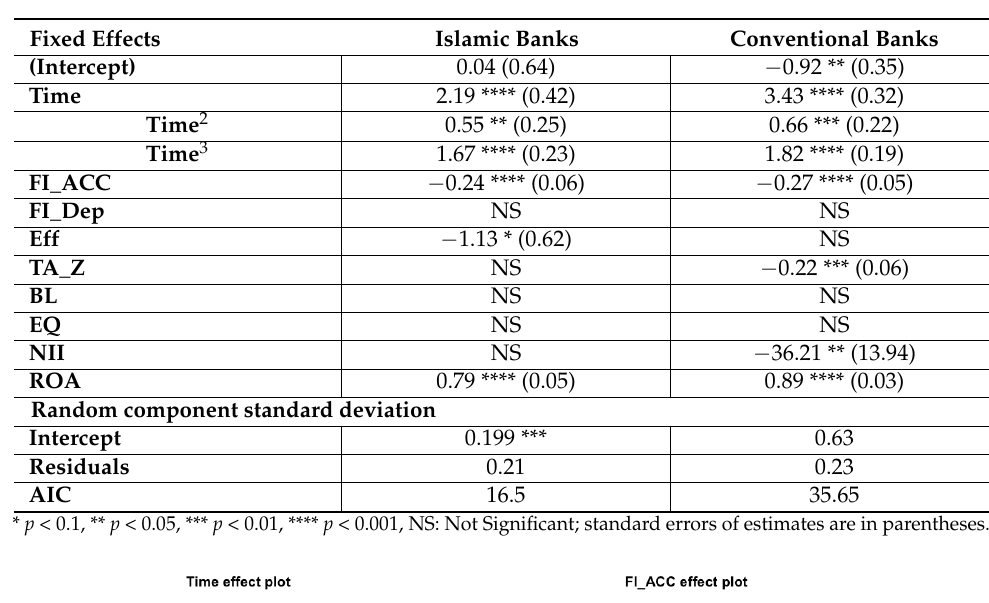
Table 6. Results of Linear Mixed Model for Islamic and conventional bank stability.